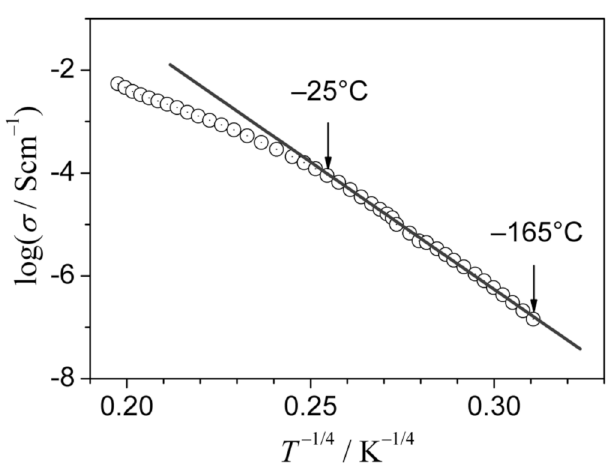
Figure 7. Conductivity of the nanocrystallized LiFe 0.75 V 0.1 PO 4 material (G10) at low temperatures in Mott’s coordinates log σ vs. T − 1/4 . The solid line is a linear fit to the experimental data (circles) (Reproduced with permission from ref. [44]. Copyright 2013,